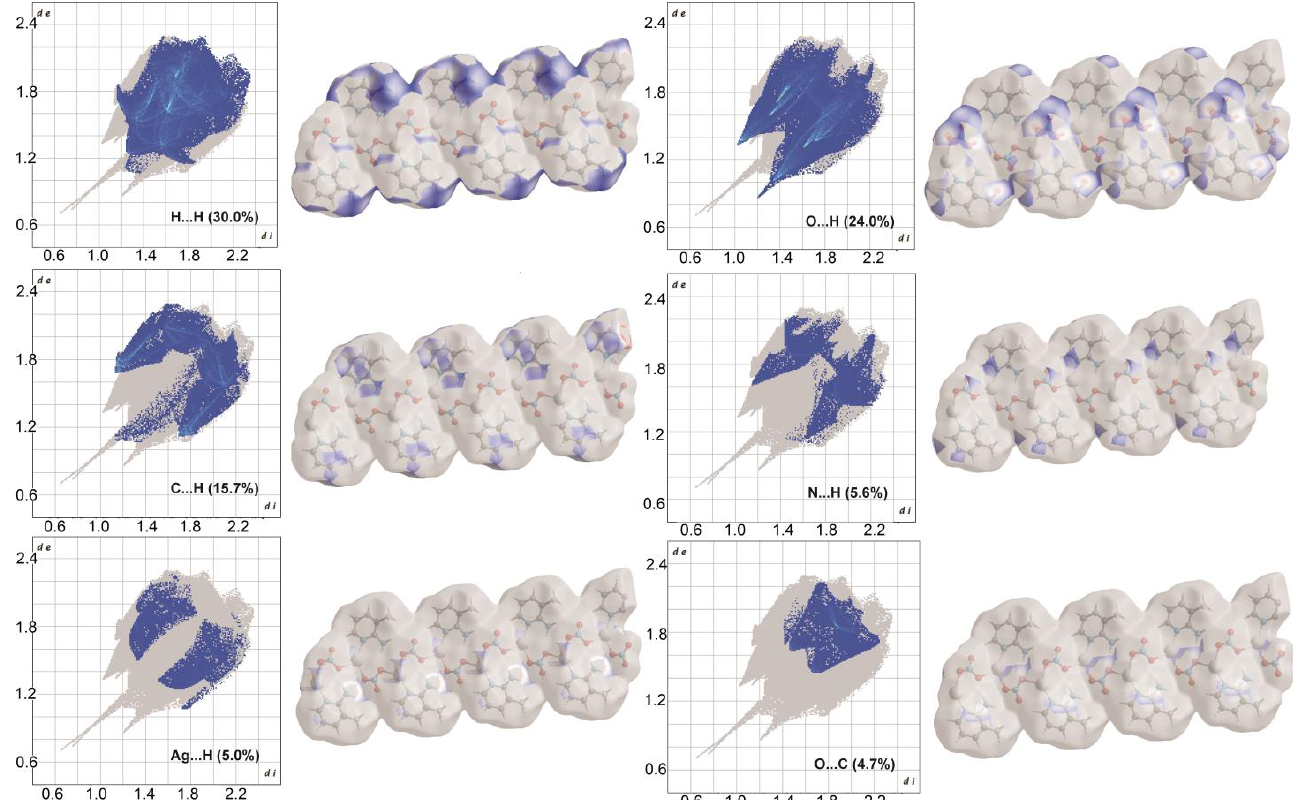
Figure 7. 2D finger plots for 4 showing intermolecular contacts. The percentage of contribution is also